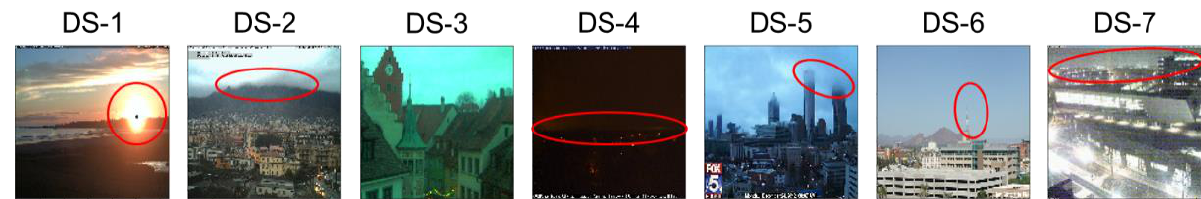
Figure 3. The difficult scenes in the Skyfinder dataset. The red circles highlight the difficult visible situation. “DS” refers to the difficult scene. DS-1, DS-2, DS-3, DS-4, DS-5, DS-6, and DS-7 refer to the strong backlight, heavy fog occlusion, color-channel shift, extremely low illumination, heavy cloud occlusion, truss structure, and heavy noises, respectively.